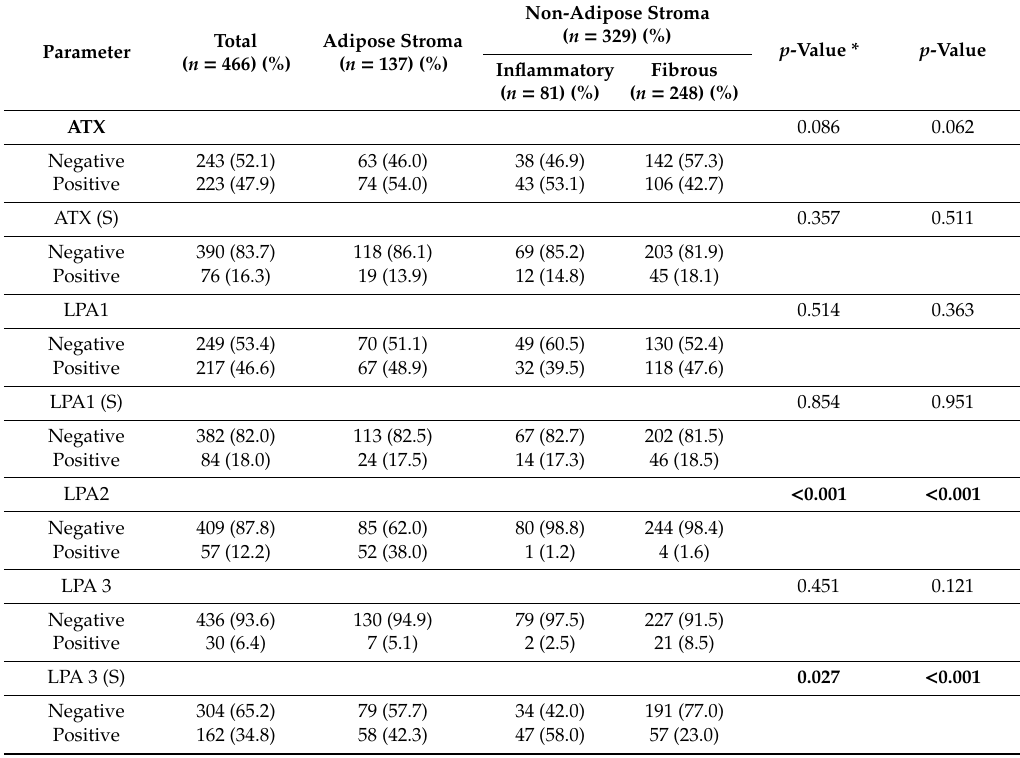
Table 3. Expression of ATX-LPA signaling-related proteins according to breast cancer stroma type.